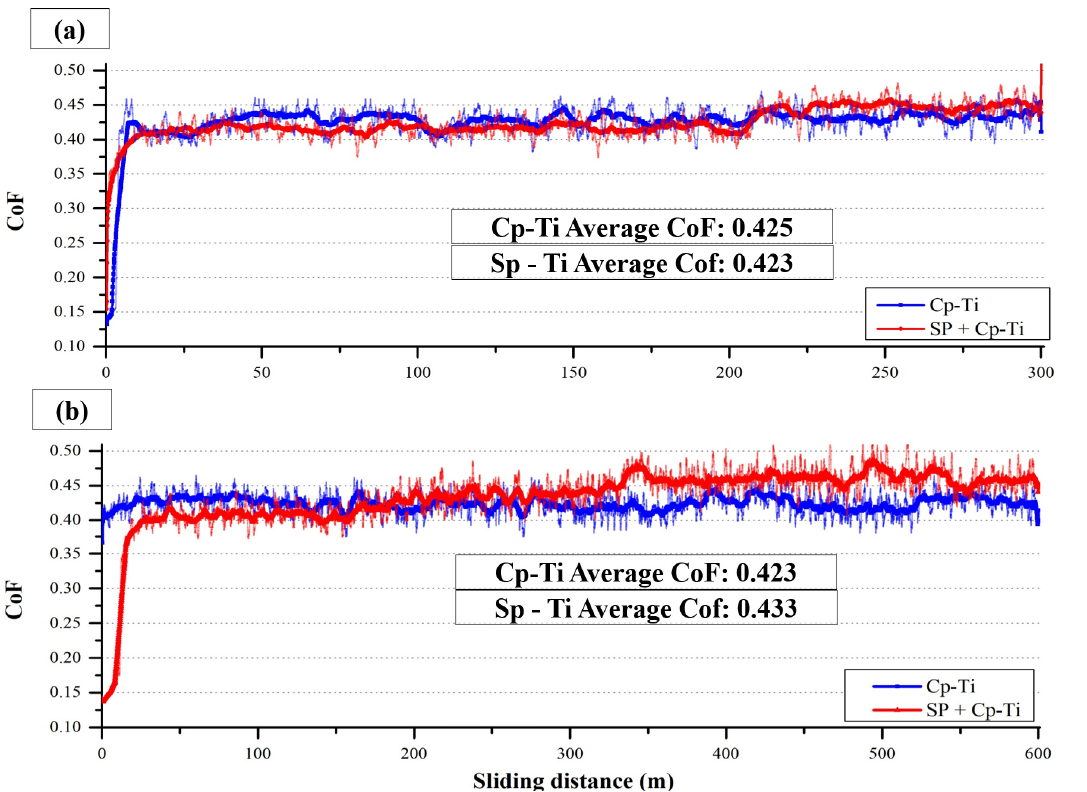
Figure 7. Coefficient of friction versus sliding distance of shot-peened (SP+Cp-Ti) and unpeened (Cp-Ti) at sliding distance of 300 m ( a ) and of 600 m ( b ).